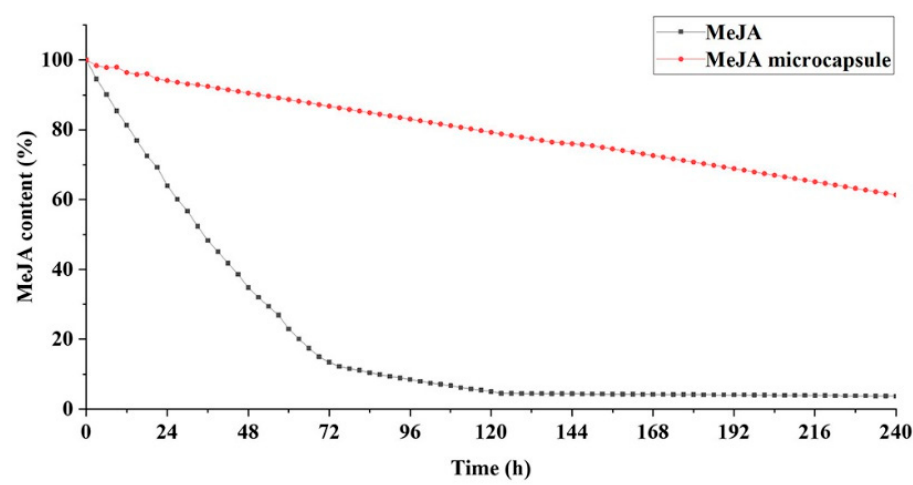
Figure 4. Methyl jasmonate content remained in methyl jasmonate microcapsules over the period of 240 h at 20 °C.